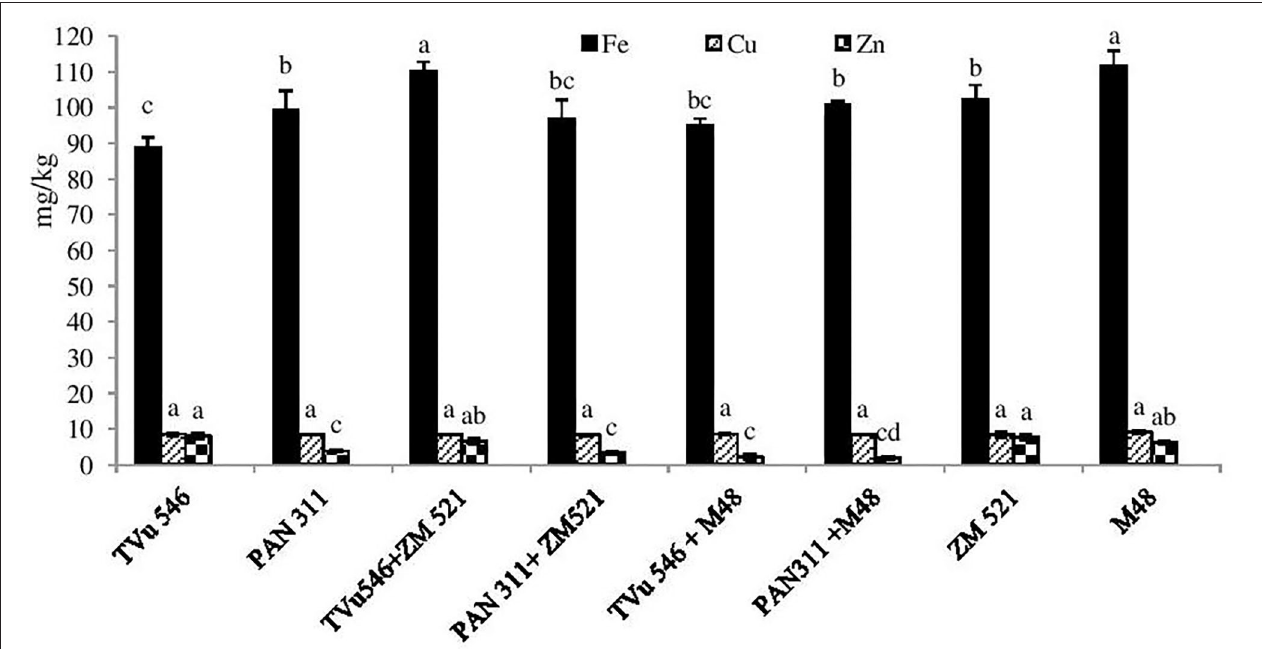
FIGURE 1 | Available micro-element in rhizosphere of solo and intra-hole planted cowpea, sorghum, and maize. Bars with dissimilar letters are significantly different ( P ≤ 0.05) for each element.